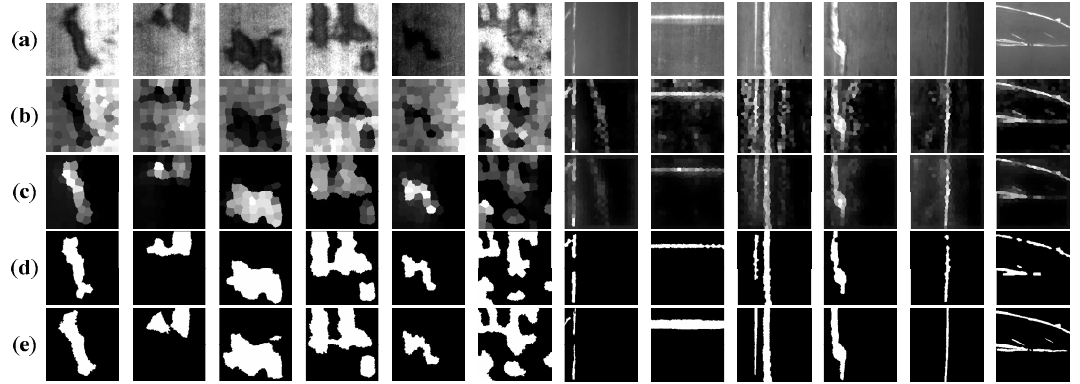
Figure 4. Segmentation results of the proposed DLRSD-based method: ( a ) input image; ( b ) original defect foreground image; ( c ) enhanced defect foreground image; ( d ) segmentation image by Otsu’s method; ( e ) manual-labeled ground-truth image.